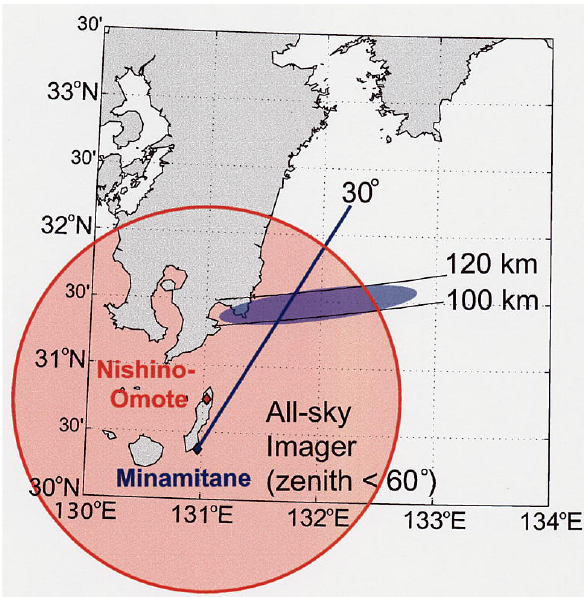
Fig. 1. Map showing location of the all-sky imager (Nishino- Omote) and VHF radar (Minamitane). Field-of-view of the all-sky imager with zenith angle less than 60 ◦ is shown by a circle (radius of 160km). Area observed with the VHF radar is also shown by the shaded area in the figure.